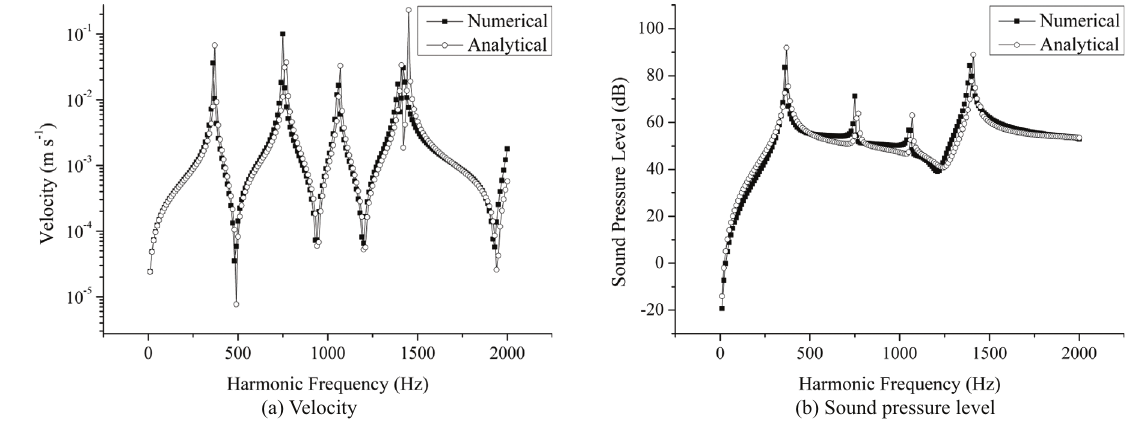
Fig. 3. Comparisons of dynamic responses Δ T = 0 ◦ C.